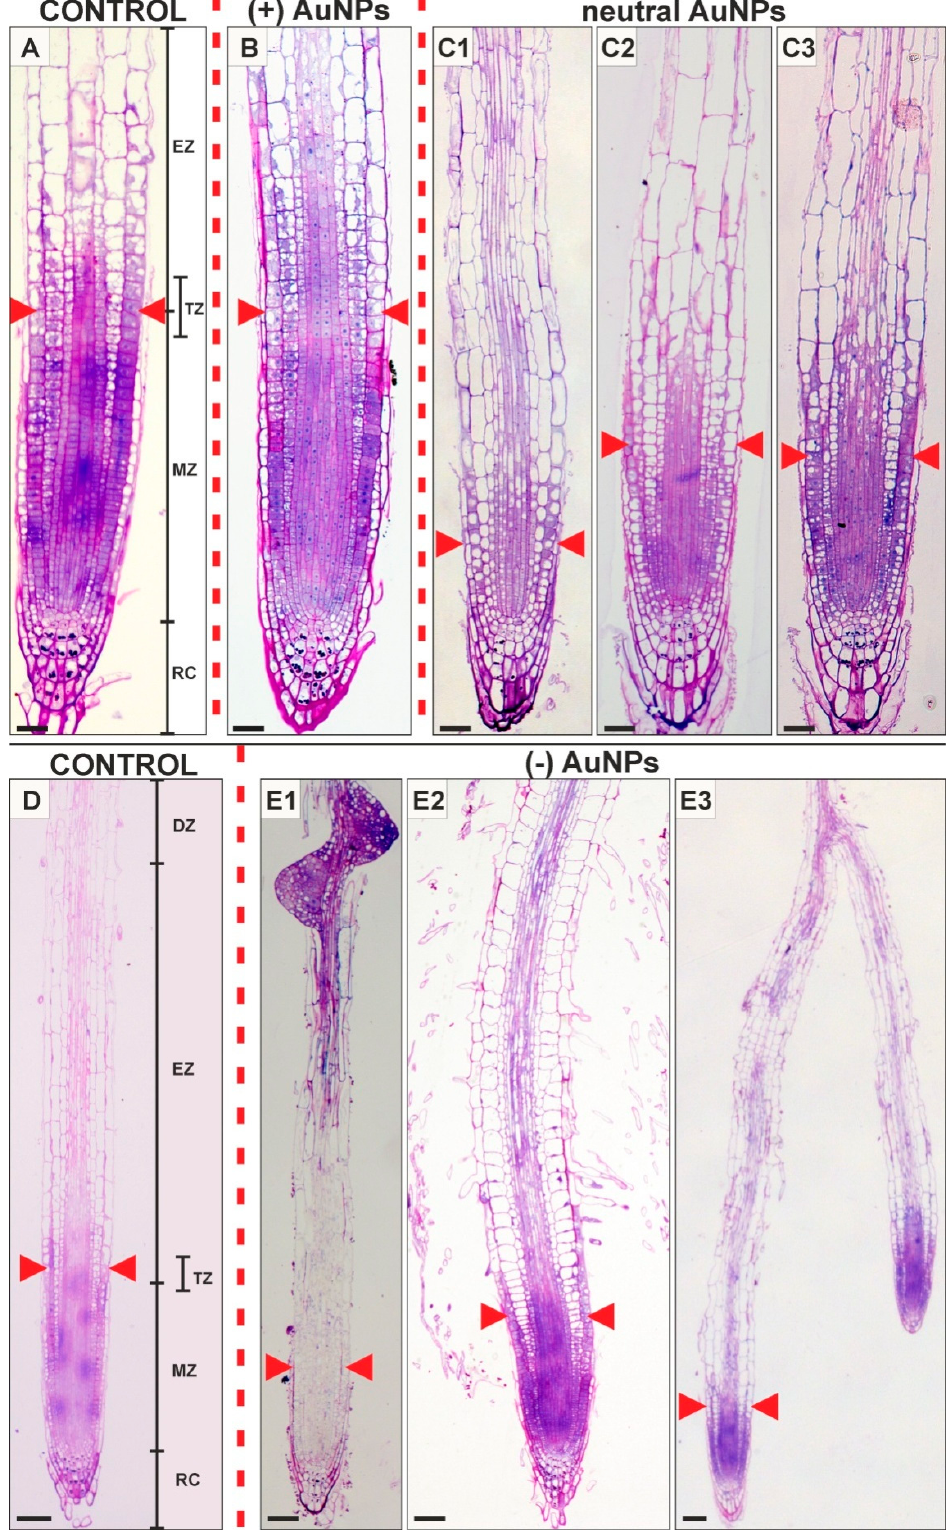
Figure 1. Longitudinal sections of Arabidopsis thaliana roots of seedlings that have been growing in control conditions ( A , D ) and treated with: (-) AuNPs (B), neutral AuNPs ( C1–C3 ) and (+) AuNPs (E1–E3 ). Red arrowheads indicate meristem boundary (the position of the first elongating cortical cell); DF—differentiation zone; EZ—elongation zone; MZ—meristematic zone; RC—root cap; TZ—transition zone. Scale bars: A–C2 = 20 μ m; D–E3 = 50 μ m.